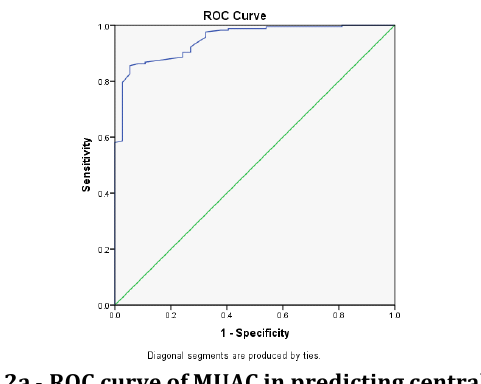
2a - ROC curve of MUAC in predicting central obesity in males